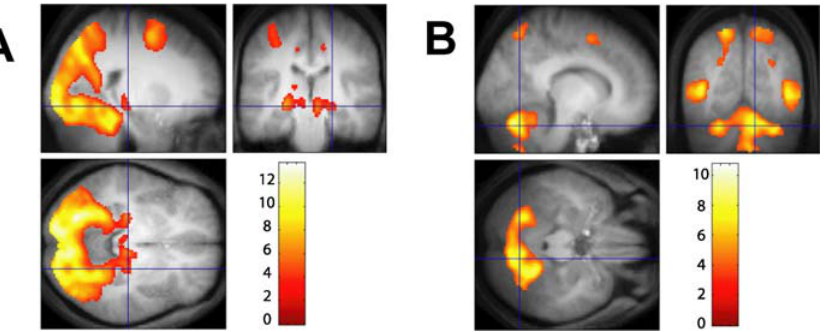
Figure 3. Practice-Related Activations (A) Brain activity during exploration of the virtual environment (Session IV). Cross hair shows hippocampus activation (22 (cid:1) 26 (cid:1) 6 mm, p corr , 0.005) superimposed on participants’ average anatomical T1-weighted MRI image. Color bars indicate magnitude of effect size. (B) Brain activity during practice of the procedural serial RT task (Session IV). Cross hair shows cerebellum activation (12 (cid:1) 74 (cid:1) 22 mm, p corr , 0.05). DOI: